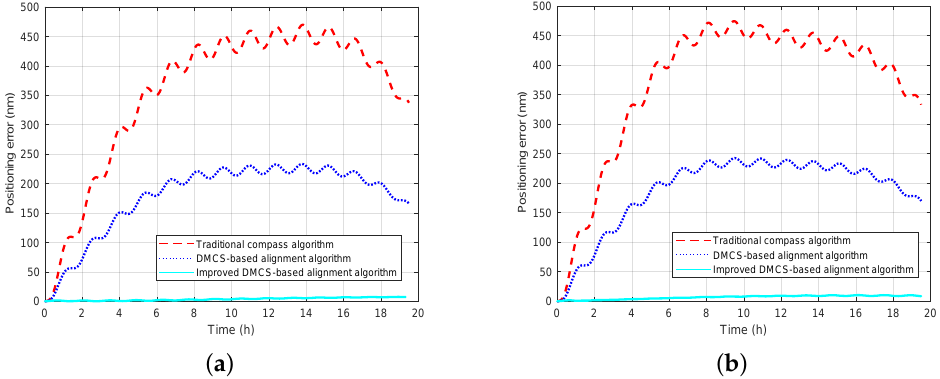
Figure 16. Positioning error curve when the initial alignment lasts 15 min. The red dashed line denotes the positioning error curve by utilizing the traditional compass algorithm under the static base; the blue dotted line denotes the positioning error by utilizing the DMCS alignment algorithm under the single-axis rotating base; the light blue solid line denotes the positioning error by utilizing the improved DMCS-based alignment algorithm under the rotating base. ( a ) Positioning error when the initial heading error is 125 ◦ . ( b ) Positioning error when the initial heading error is − 170 ◦